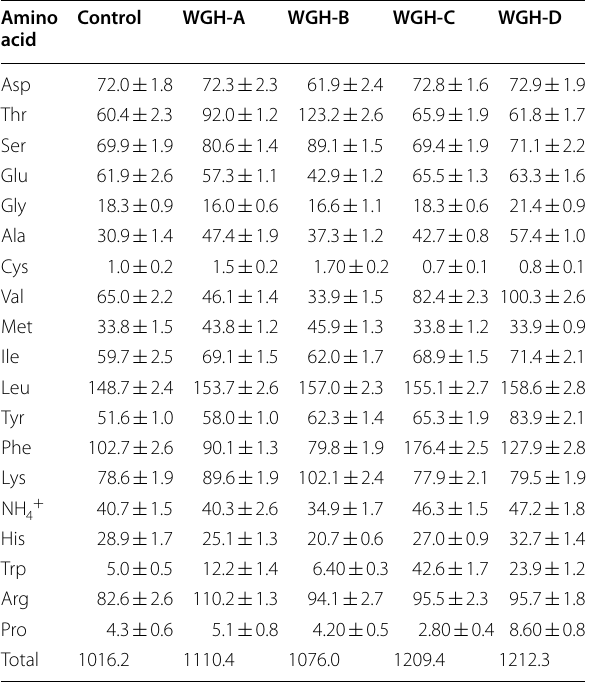
Table 3 Absorption of amino acids in VHG worts fermentation (mg/L)